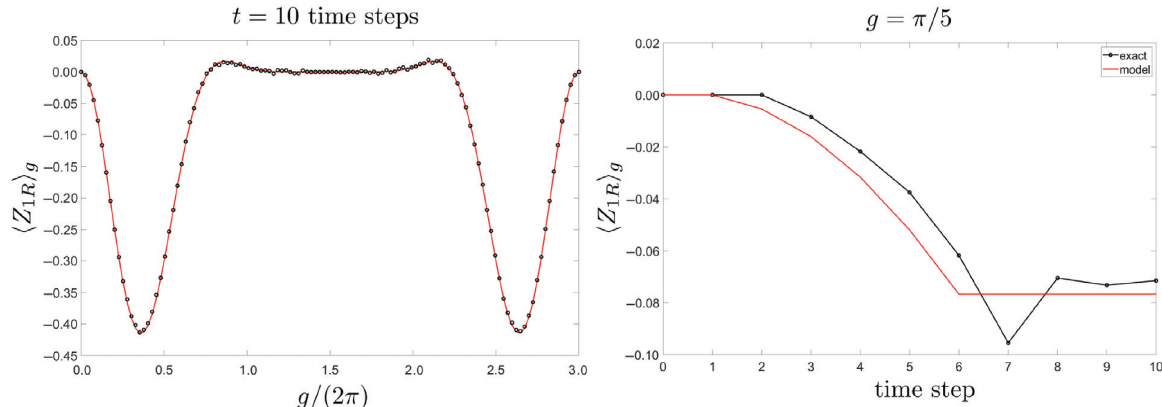
FIG. 5. The expectation value of Z 1 R after injection of a Z 1 L = 1 state on the left system. The black dots are direct numerical simulation of the protocol in the quantum kicked Ising model with n = 7 spins on the left and right and with J = b = π/ 4 and h i drawn from a box distribution of width 0.5. Left: the signal at fixed large time as a function of g . The black circles are the exact numerical simulation. The red curve is the theory prediction in Eq. (20). Right: the signal at fixed g as a function of the time step. The black circles are the exact numerical simulation. The red curve is a crude approximation where we assume that Eq. (20) holds at all times, with the effective system size replaced as n → min ( t + 1, n )